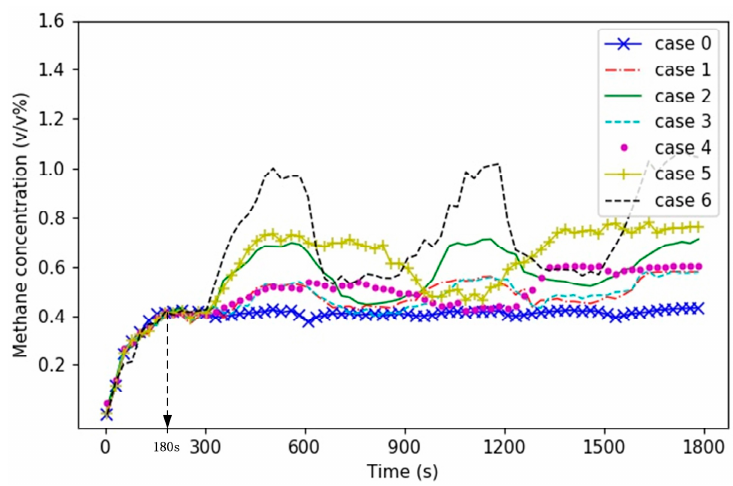
Figure 7. Average methane concentration in a selected point at different times.